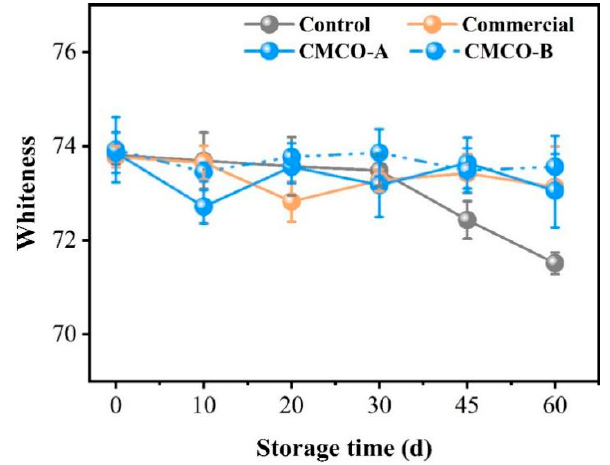
Figure 8. Effects of the CMCO on whiteness of the gels prepared from frozen surimi at different storage time.